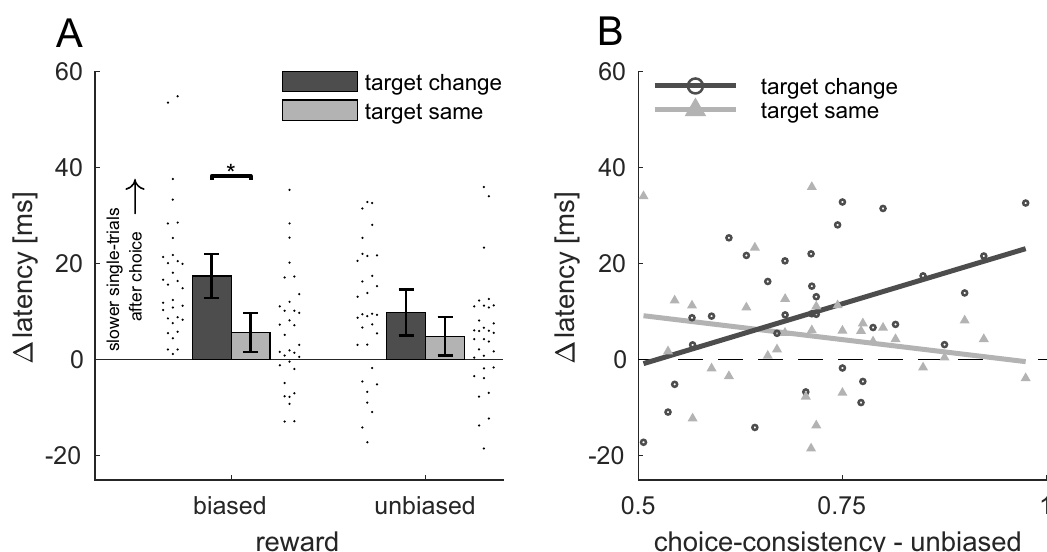
Fig 4. Inter-trial effects. (A) Latency differences between choice-single and single-single sequences for the four different sequence types. Error bars denote 95% confidence intervals of between-participant variability. Black dots next to each bar graph denote values of individual participants in that respective condition. The asterisk indicates a significant difference (p < 0.05). (B) Unbiased inter-trial effects as a function of choice-consistency. Data points denote individual participants, solid lines are linear regressions for the target change (dark) and same (light) condition. Target change and same data of one individual can be linked by the same value of choice consistency on the x-axis.